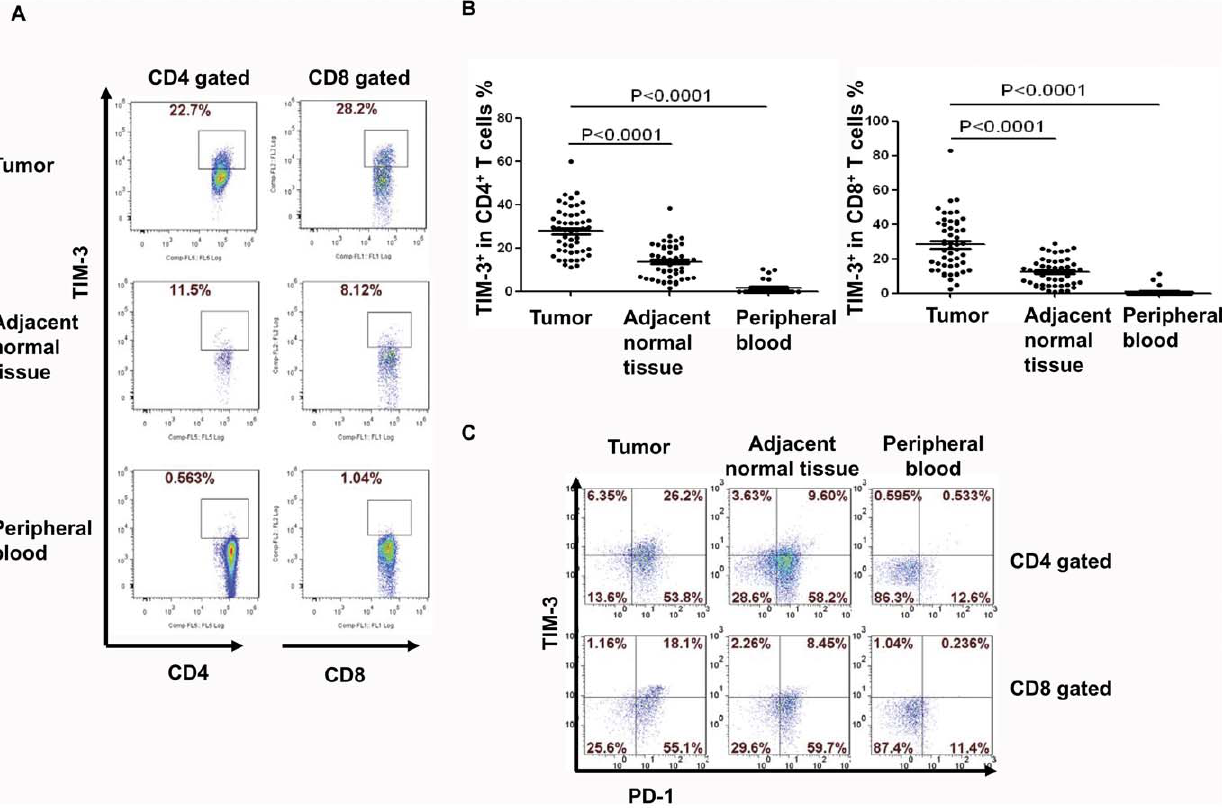
Figure 1. TIM-3 is highly expressed on both CD4 + and CD8 + tumor infiltrating T cells in lung cancer. Tumor infiltrating lymphocytes (TILs) were harvested from lung cancer tissues, adjacent normal tissues, and peripheral blood monouclear cells (PBMCs) from whole blood of patients. Cells were then stained for CD4, CD8, TIM-3 and PD-1. A. Representative dot-plots show TIM-3 expression on CD4 + and CD8 + T cells in various tissues from lung cancer patients. Lymphocytes were gated for further analysis of CD4 and CD8 T cells. More than 90% CD4 + or CD8 + cells were CD3 + . B. Summarized results of the percentage (%) of TIM-3 expression on CD4 + and CD8 + T cells from lung cancer patients are shown. Horizontal bars depict the mean percentage of TIM-3 expression on CD4 + and CD8 + T cells. Error bars: s.e.m. C. Dual expression of TIM-3 and PD-1 on gated CD4 + and CD8 + T cells is shown. The p-values were calculated using the one-way ANOVA.